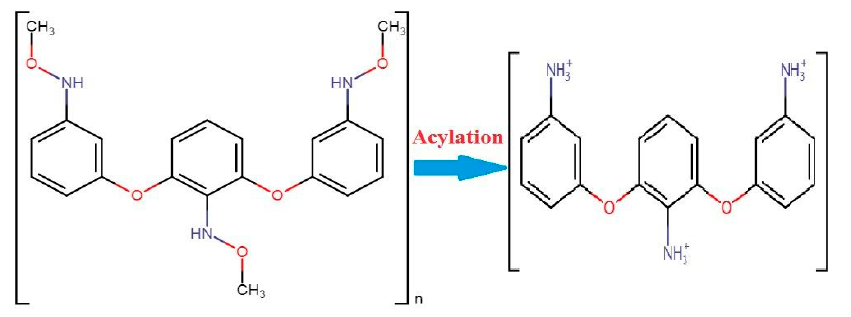
Figure 8. The conversion of chitin into chitosan under the process of acylation [95].